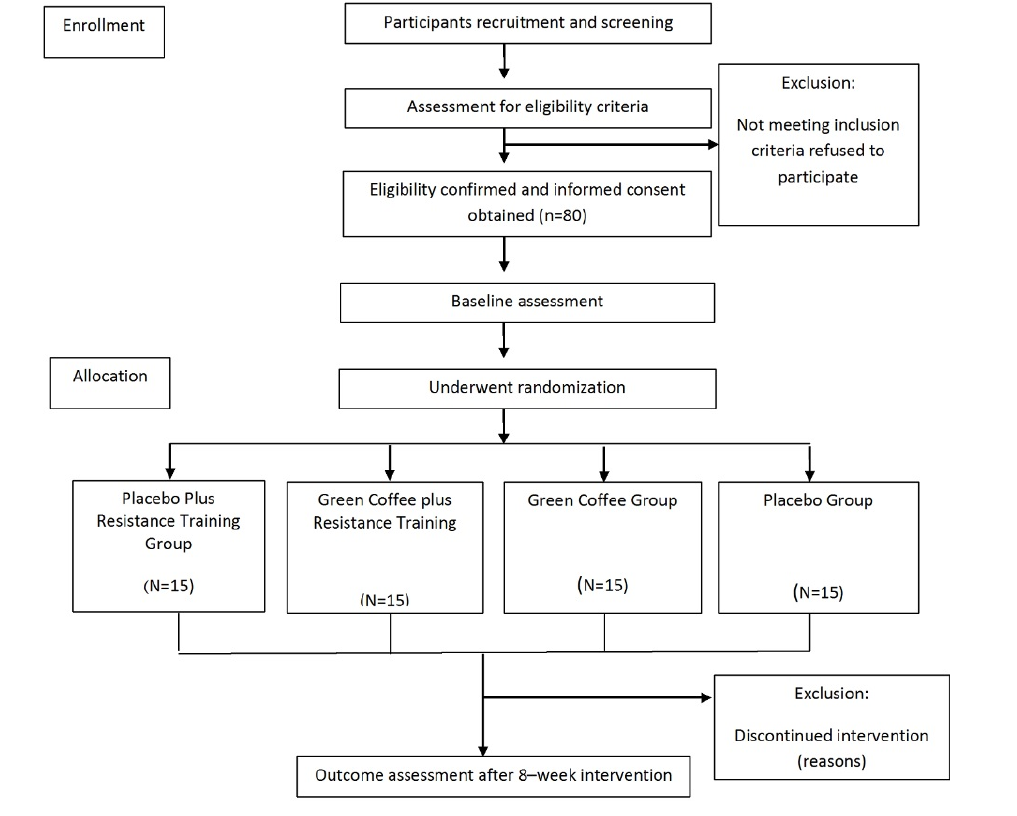
Figure 1. CONSORT flow diagram